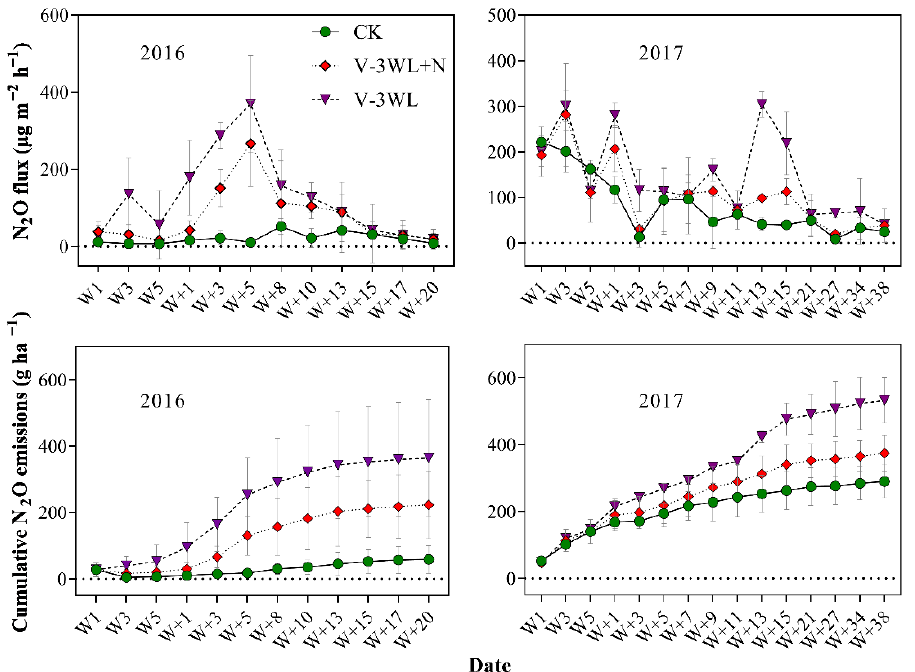
Figure 1. Effects of applying nitrapyrin on the soil N 2 O emission flux under a waterlogged field. 193 V-3WL, waterlogging treatment with urea application only; V-3WL+N, waterlogging treatment 194 with urea and nitrapyrin application; CK, not waterlogged, but applied only urea; Wn, 195 waterlogging duration; W+n, the day after waterlogging. The error bars represent 95% confidence